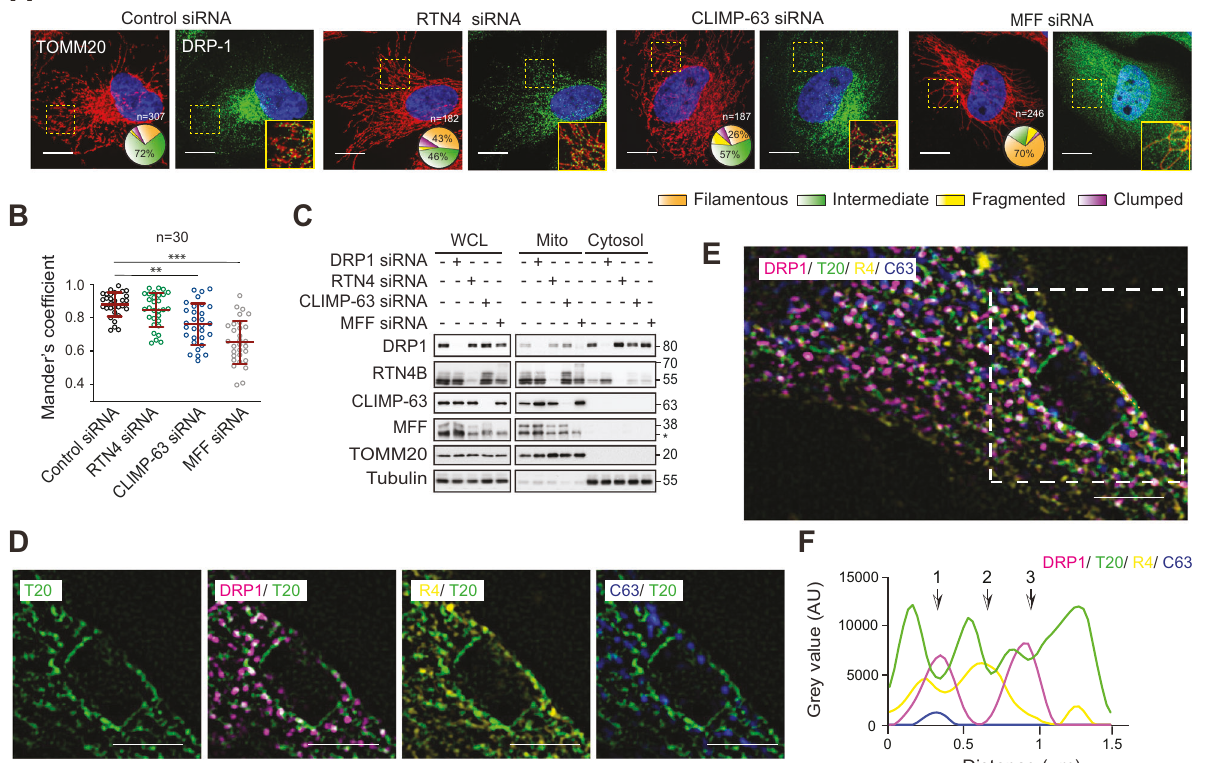
Fig. 4 Silencing of ER shaping proteins does not alter mitochondrial recruitment of DRP1. A HeLa cells were transfected with either a control, RTN4, CLIMP-63 or MFF siRNA (as a positive control) for 72 h, then immunostained using antibodies against DRP1 (green) and TOMM20 (red). Mitochondrial morphologies were quanti fi ed in the indicated numbers of cells ( n ) per condition, across a minimum of 3 independent experiments, and the data plotted in pie charts here, and as bar graphs in Supplementary Fig. 13. Areas demarcated by the dashed yellow boxes are merged and magni fi ed in the rightmost panel of each condition. Scale bars are 10 μ m. B The extent of colocalisation of DRP1 foci with mitochondria (TOMM20), represented by Mander ’ s coef fi cient, was calculated from a de fi ned ROI per cell in 30 different cells per condition. In the graph, each dot represents one ROI. Data are displayed as mean ± SD, ** p ⩽ 0.005, *** p ⩽ 0.001 (Kruskal-Wallis test, with Dunn ’ s multiple comparisons test). C Western blots of the indicated proteins in whole cell lysates (WCL), as well as fractions corresponding to mitochondria (Mito) and cytosol, isolated from cells transfected as detailed in A . A non-speci fi c band in the MFF blot is denoted with an asterisk (*). D HeLa cells were immunostained using antibodies against DRP1 (magenta), RTN4 (R4; yellow), CLIMP-63 (C63; blue) and TOMM20 (T20; green) and subjected to superresolution microscopy. E Superresolution image of the cell immunostained in D , in which the white dashed square corresponds to the ROI shown in D . Scale bars are 2 μ m. F Relative intensity plots, depicted as Grey value in absorbance units (AU) of the indicated markers, for the dashed line (in orange) drawn within the ROI in E . The arrows labelled 1 – 3 correspond to potential mitochondrial constriction/ fi ssion